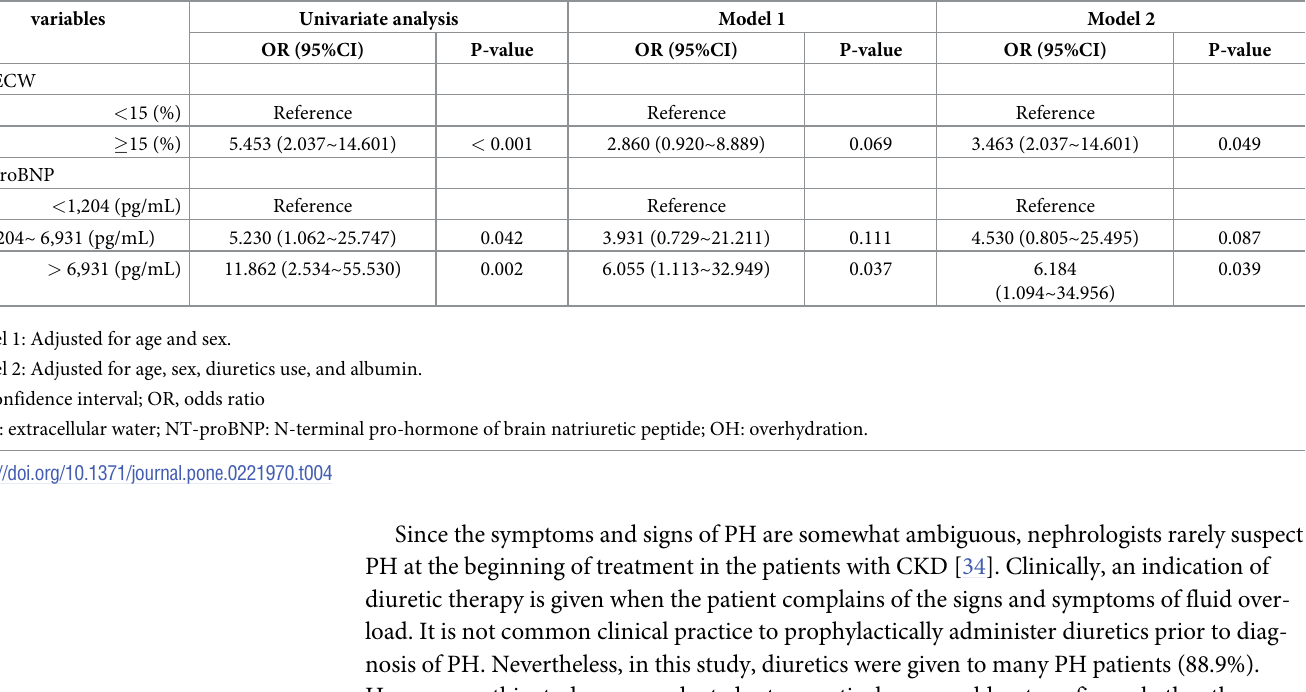
Table 4. Multivariate analysis using logistic regression: Predictive factors for the risk of pulmonary hypertension group.